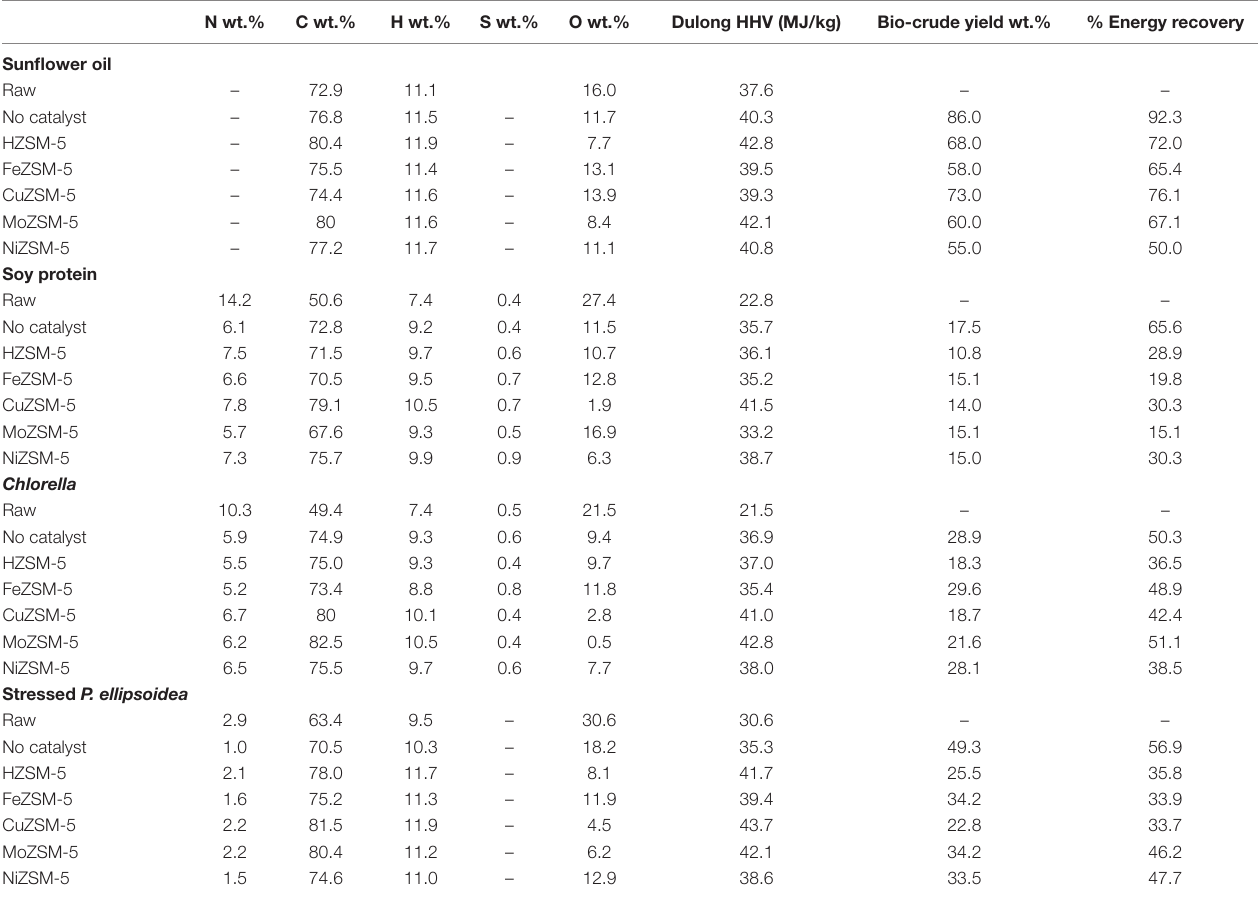
TaBle 5 | elemental composition and the bio-crude yield as received of the bio-crude oils using the different catalysts in water and the % of energy recovery. n